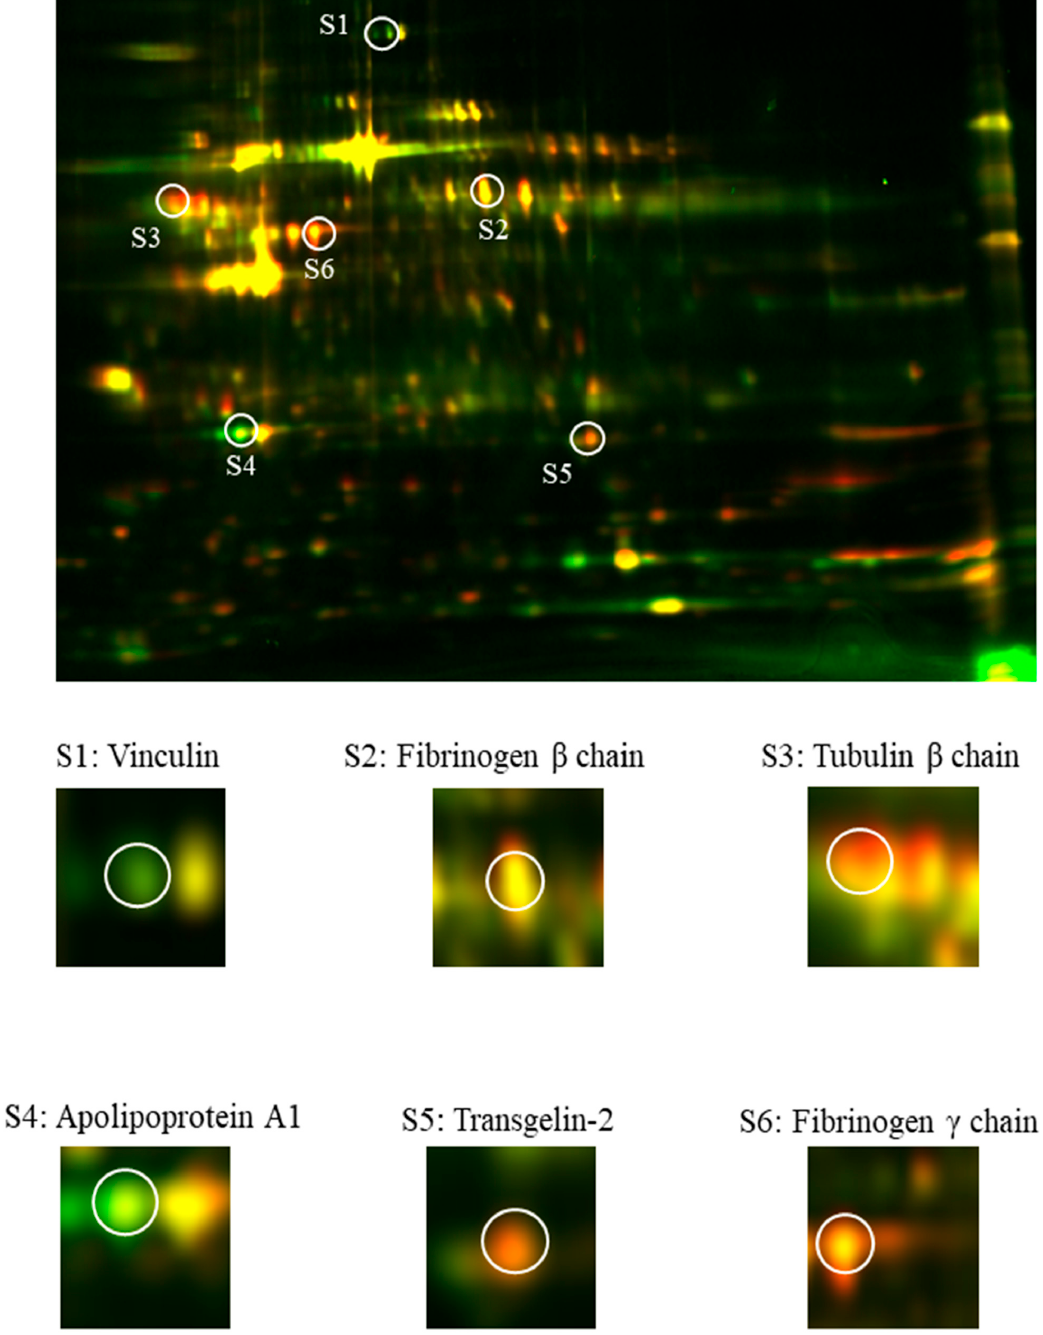
Figure 2. Identification of selected protein spots from blood platelets of ACS patients via nanoscale liquid chromatography coupled to tandem mass spectrometry.